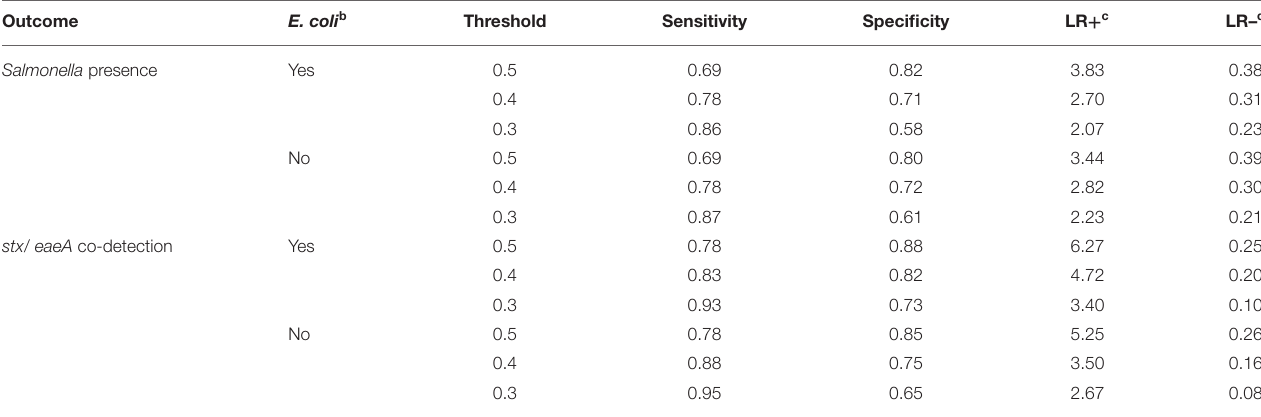
TABLE 4 | Differences in performance measures for the conditional forest models displaying the relationship of the pathogen detection outcomes ( Salmonella presence and EHEC marker detection) with the land use, weather, sampling site characteristics, and water quality predictors with generic E. coli level included and excluded as a predictor a